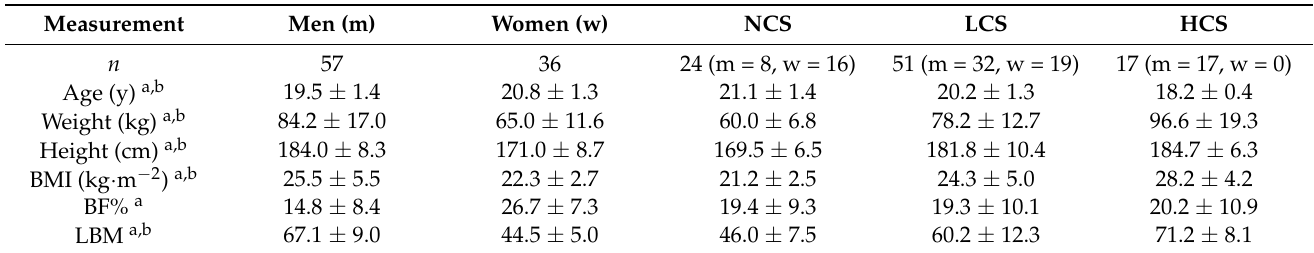
Table 1. Participant